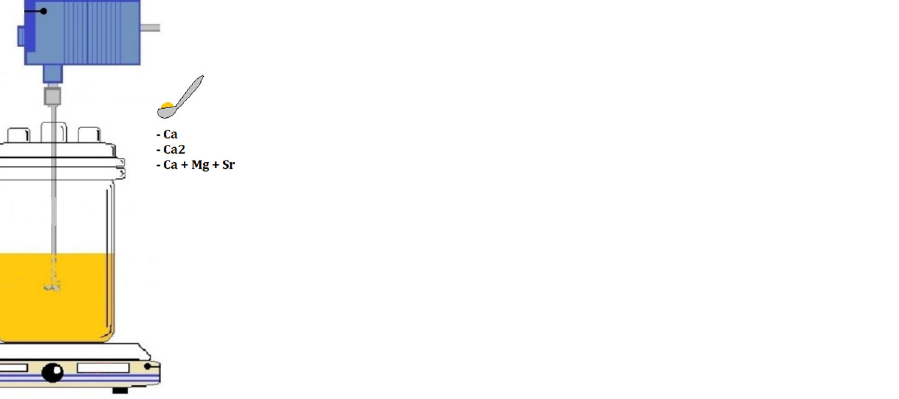
Figure 2. Experimental setup for the synthesis of doped jarosite-type compounds, pH 1.7, 70 °C, 500